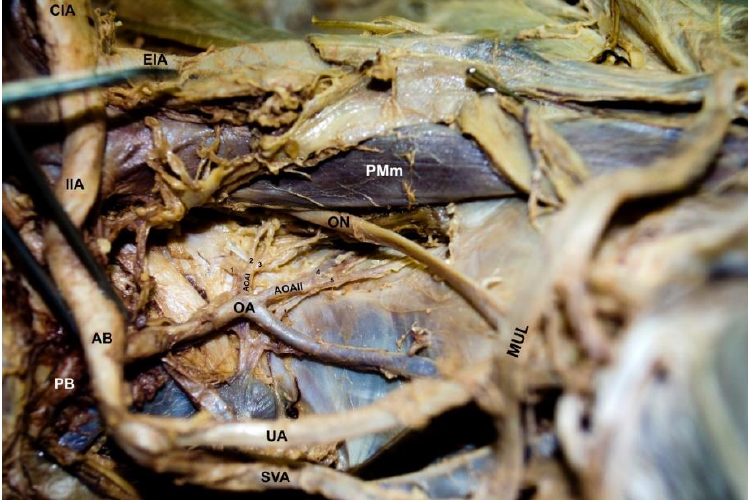
Figure 1. Illustration showing the atypical findings in the pelvic region presented in the case report. The common iliac artery (CIA) passes through the psoas major muscle (PMm) and divides into the external iliac artery (EIA) and internal iliac artery (IIA). The artery travels along the obturator fascia of the obturator internus muscle (OIM) of the pelvic sidewall, between the obturator nerve (ON) and obturator vein. A variation was found with multiple branches in its course before leaving the pelvic cavity through the obturator foramen. The anterior branch (AB) of the internal iliac artery (IIA) provided the obturator artery (OA) branch, divided into two atypical OA-provided anatomi- cally variant branches. Abnormal obturator artery I (AOAI) gave rise to three branches (1, 2, 3), while abnormal obturator artery II (AOAII) gave rise to two branches (4, 5). In addition, anterior branches (AB) such as the umbilical artery (UA), superior vesical artery (SVA), uterine artery and other branches from the posterior branch (PB), superior gluteal artery (SG), lateral sacral artery, and iliolumbar artery were anatomically oriented.